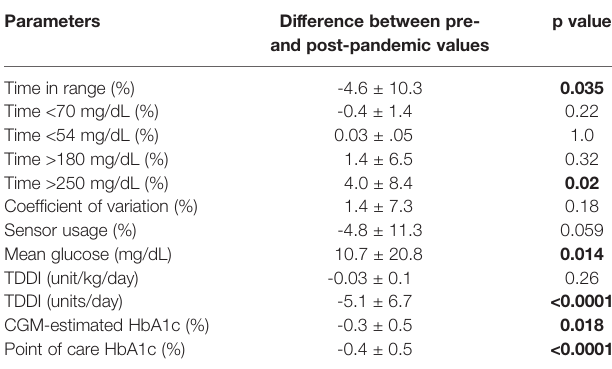
TABLE 5 | The principal predictors of improved glycemic control in the CGM users during the pandemic lockdown and the resulting change in A1c. Parameters Difference between pre- p value and post-pandemic values